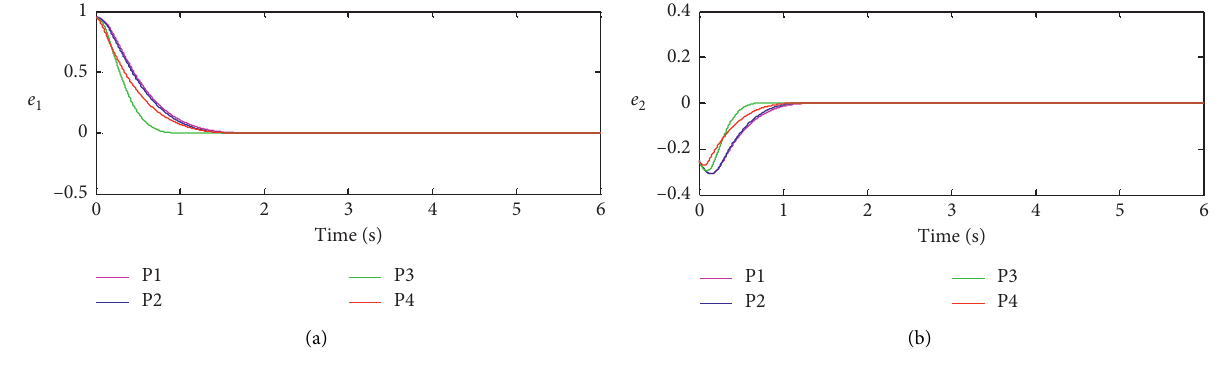
Figure 9: Position tracking errors with different parameters.